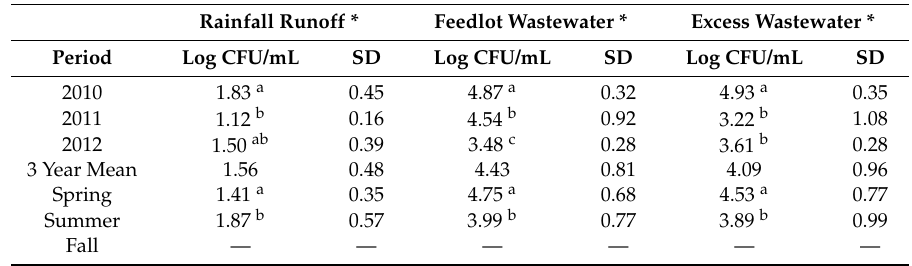
Table 2. Annual average abundance of tetracycline resistant bacteria in